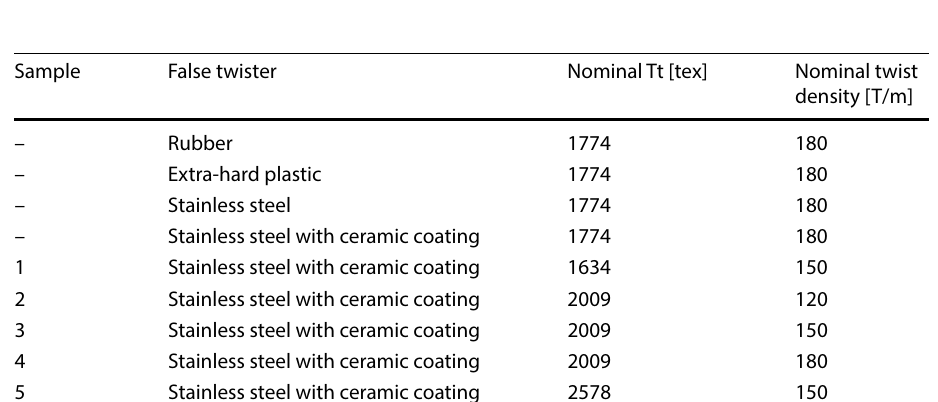
Table 1 Experimental investigation on the influence of false twister, yarn count and twist density on yarn irregularity and mechanical properties of metal spun